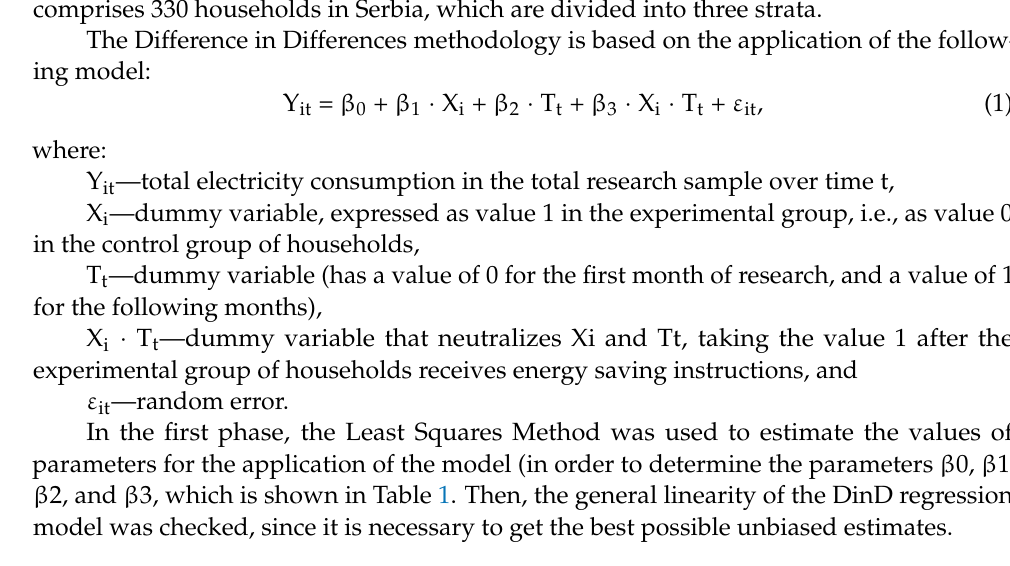
Table 1. Input data for the application of regression analysis to estimate electricity consumption in 330 households in Serbia (January–April 2019). Y X